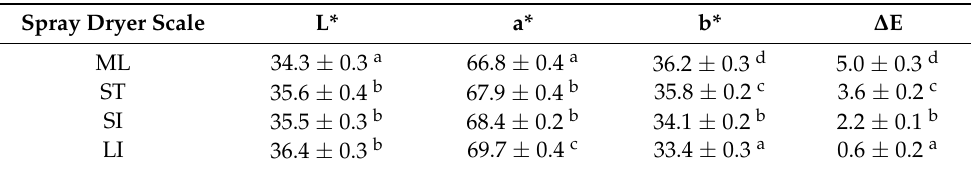
Table 3. Results for color parameters of 1% aqueous solutions of beetroot powders (mean ± standard deviation of 3